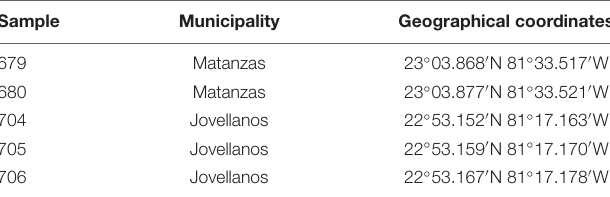
TABLE 1 | Location of Corchorus siliquosus plants showing yellow vein symptoms sampled in the province of Matanzas, Cuba.